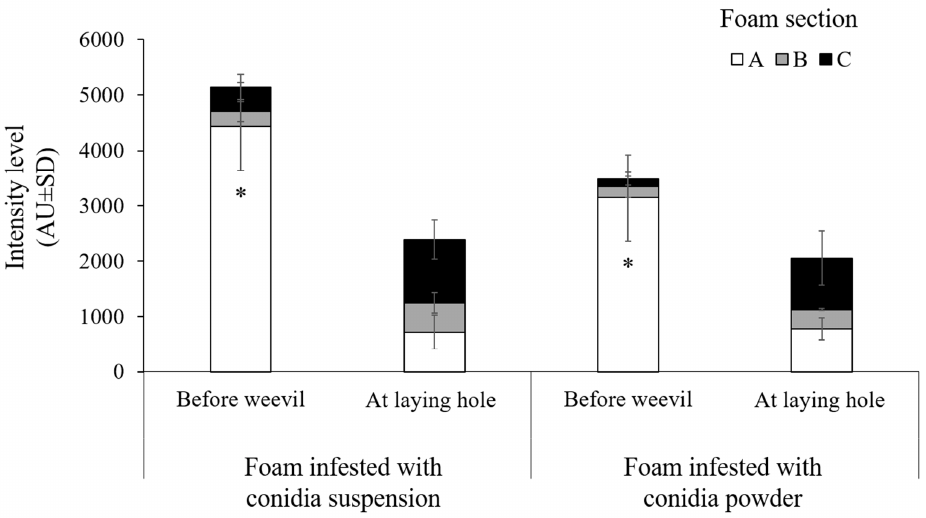
Figure 6. Dissemination of conidia from surface into laying hole. Intensity level (arbitrary units AU ± SD) measured by ImageJ software of Confocal laser scanning micrographs of Mb7-GFP-treated foam pieces with conidia suspension (10 8 conidia mL − 1 ) or conidia powder (5 × 10 8 conidia total) before weevil entry to the microcosms and after fi ve days from weevil entry, at laying holes. Three